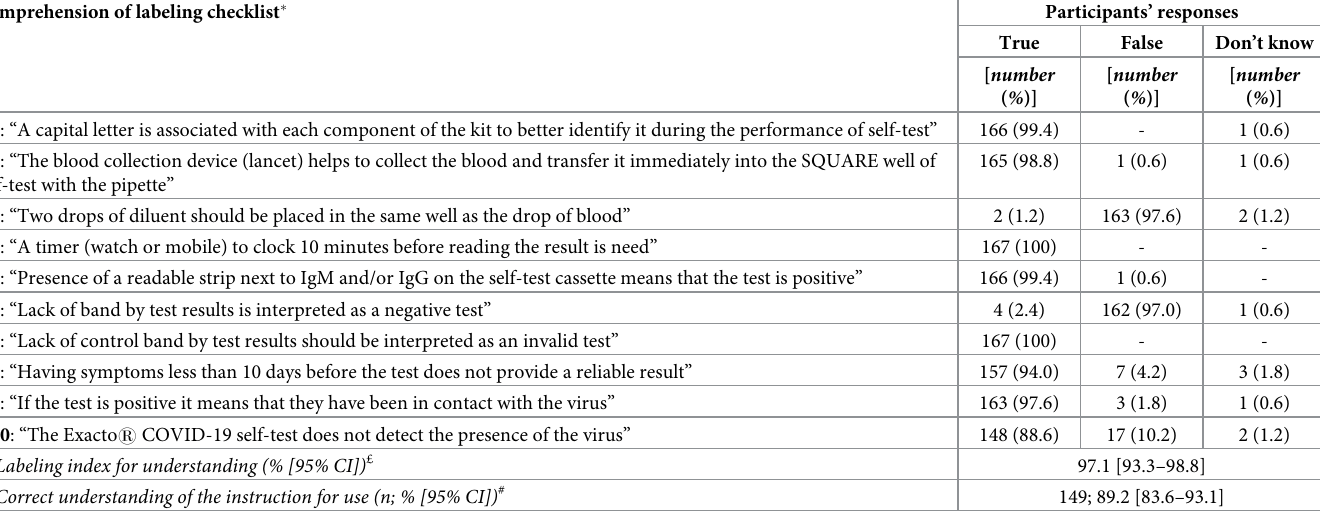
Table 2. Analytical results of the evaluation questionnaire concerning the ability of the 167 study participants to understand the instruction for use of the Exacto 1 COVID-19 self-test (Biosynex Swiss SA) (substudy 1). The questions raising specific issues concerning the manipulation of the kit, the interpretation of test results, and the consequence of test results, were asked by the observer and the answers were